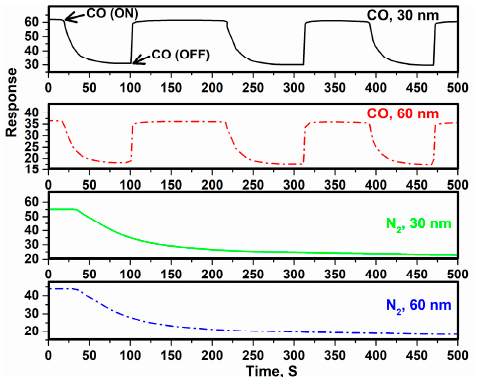
Figure 11. The response of the sensor in the CO and N 2 environments.